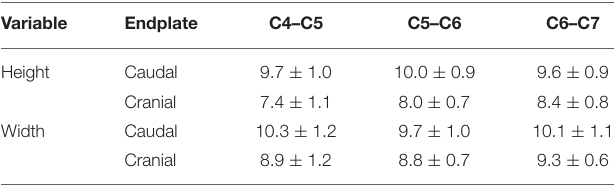
TABLE 1 | Dimensions (means ± SD) of the cranial and caudal cervical vertebral endplates in small-breed dogs. Variable